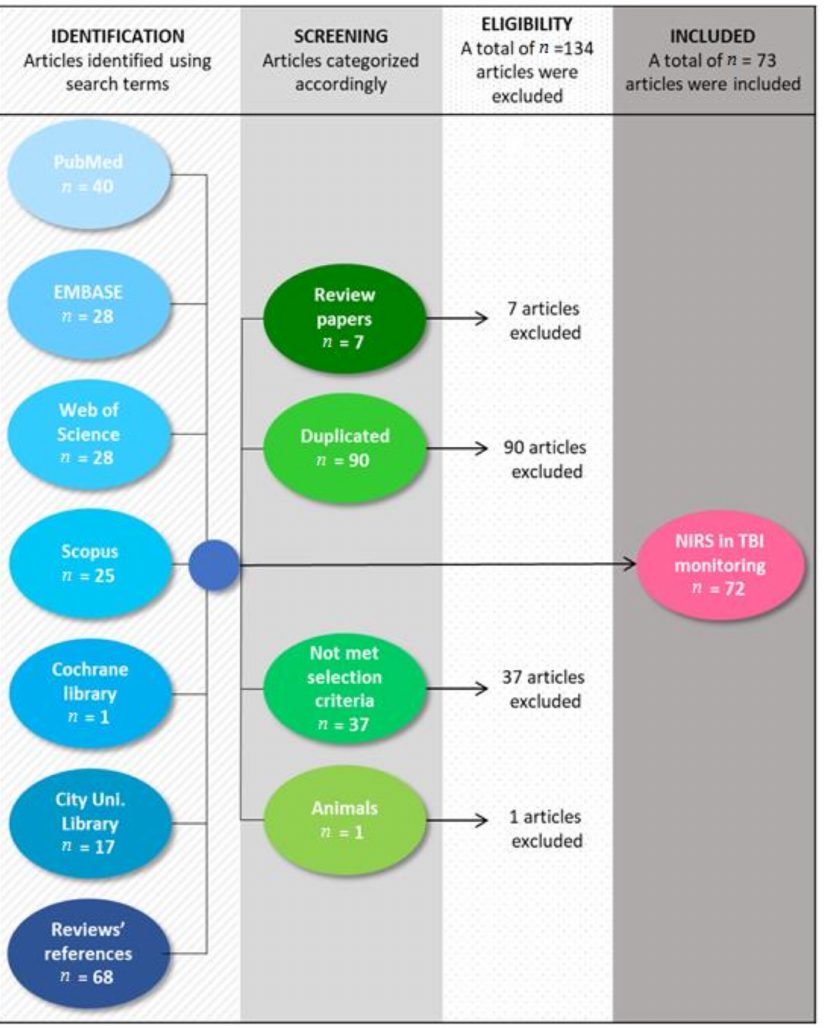
Figure 1. Flowchart of the methodology used to include 72 out of 207 studies published